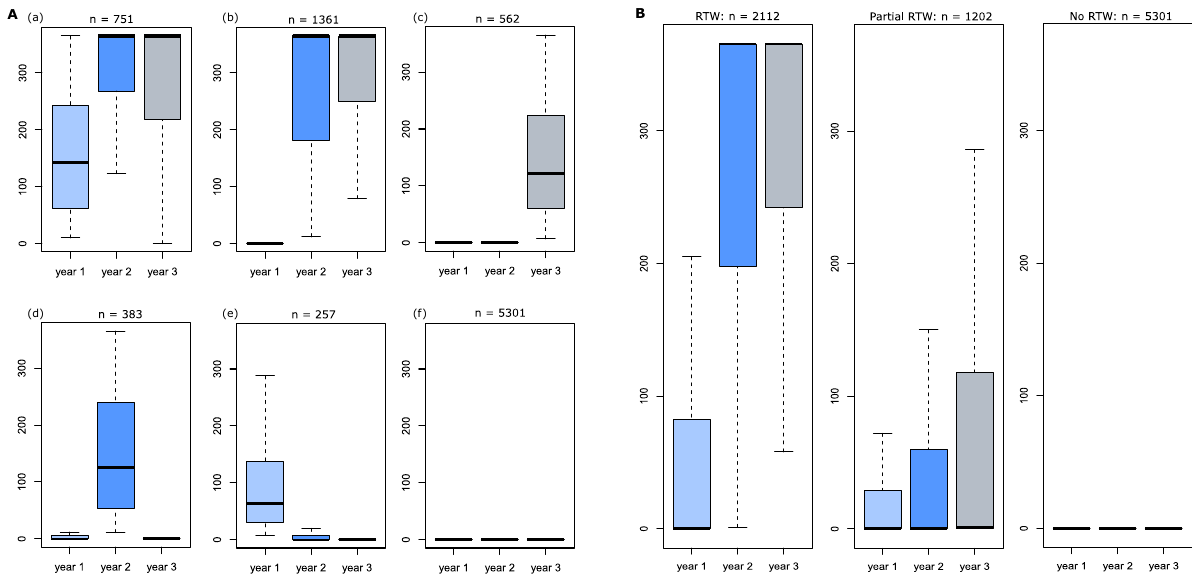
Fig. 1 The patterns of returning to work obtained by clustering analysis. The numbers of days at work of the people in clusters a – f ( A ), and groups 1 – 3 ( B ) during the 3 years follow-up. Clusters a and b are within the RTW group, whereas clusters c – e are within the partial RTW group. The cluster f had none or only few days at work, and thusthey form the no RTW